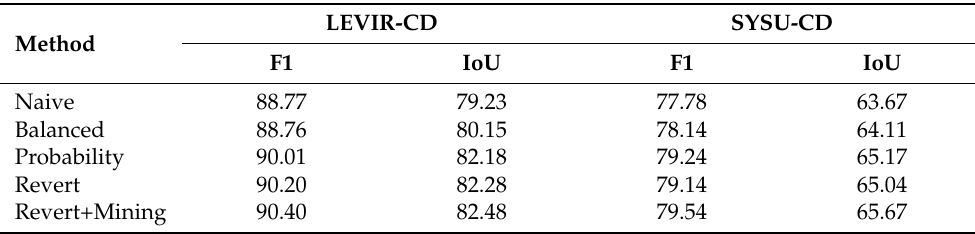
Table 3. The accuracy on different modifications of contrastive loss. Naive, Balanced, Probability, Revert, and Revert+Mining correspond to the contrastive loss modifications in Section 3.